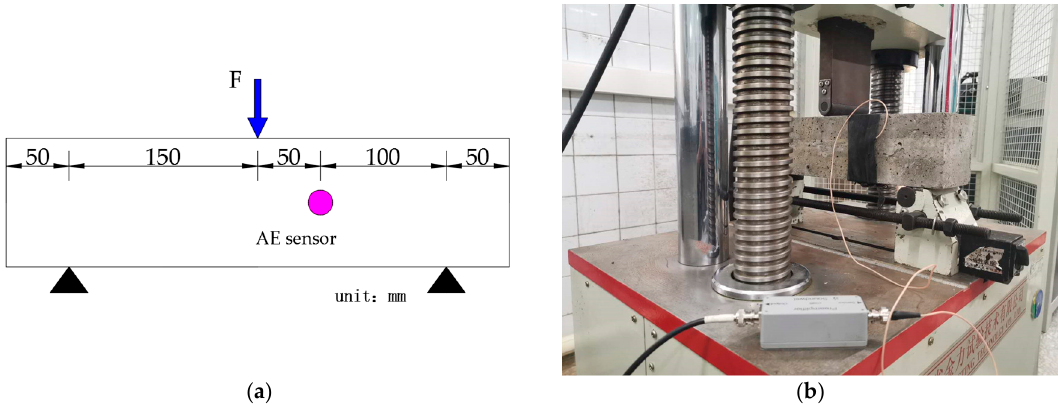
Figure 4. The arrangement of AE sensors: ( a ) schematic diagram; ( b ) specific arrangement.